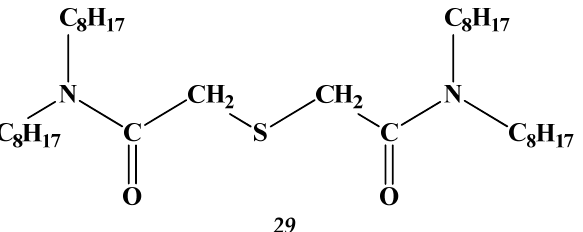
Table 3. Distribution ratio values obtained by extraction with compound 29 in n -dodecane (condi-